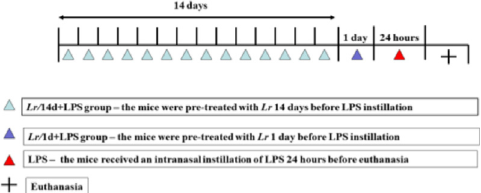
Fig. 1. Times schedule of pre-treatment time with Lacticaseibacillus rhamnosus and induction of acute pulmonary in fl ammation. Male C57BL/6 mice were anes- thetized with ketamine (100 mg/kg) and xylazine (10 mg/kg) intramuscular and exposed to Escherichia coli O111: B4 lipopolysaccharide (0.5 mg/Kg, intrana- sal, 24 h before euthanasia) to induce acute pulmonary in fl ammation. The mice were divided into two groups of Lr treatment (10-CFU/300 µ LPBS/mouse, oro- gastric by gavage), as described herein: Lr /1d+LPS group ‒ the mice were treated with Lr 1 day before LPS instillation; Lr /14d+LPS group ‒ the mice were treated with Lr 14 days before LPS instillation. The mice were euthanized 24h after the LPS.